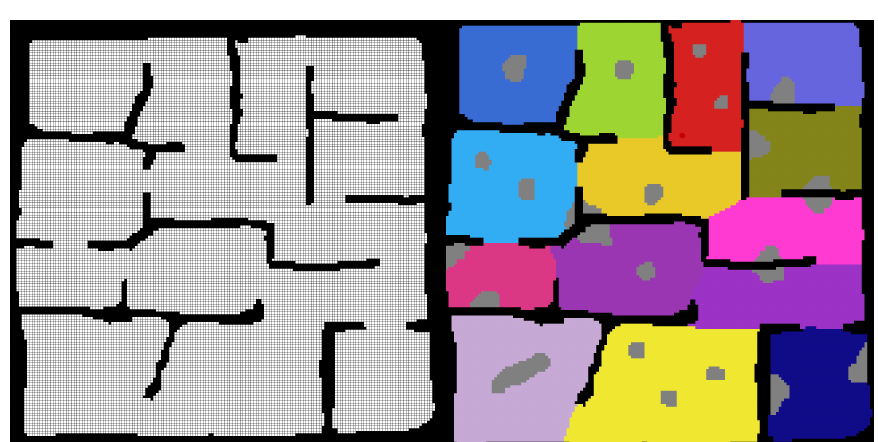
Figure 3. Map Creation: Defining the Known Obstacles, Search Regions and Unknown Obstacles. Black Cells : Known Obstacle Cells, White Cells : Explored Empty Cells, Grey Cells : Unknown Obstacle Cells, Coloured Cells : Unexplored Empty Cells (Search